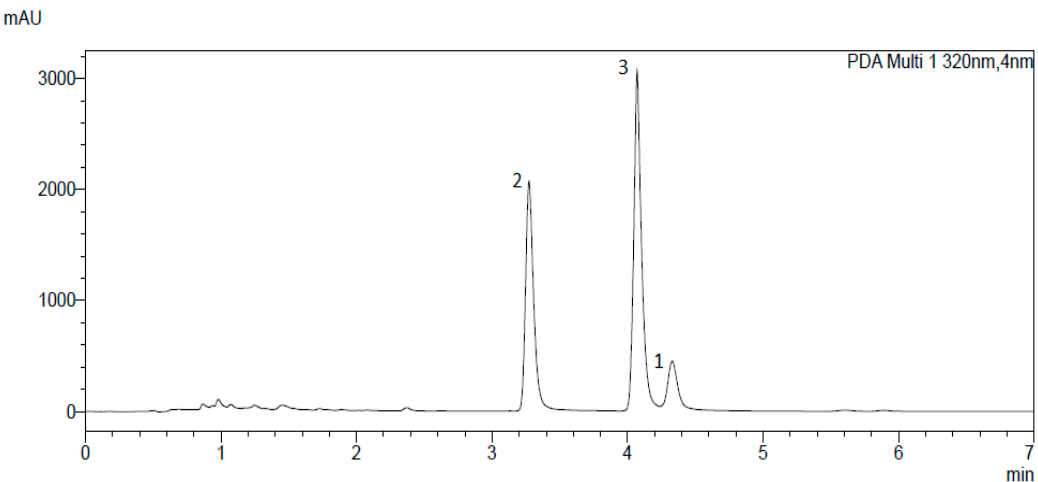
Figure 2. Chromatogram of α -acid separation. Compound 1 = adhumulone; compound 2 = cohumulone; compound 3 = n -humulone. See text for further details.